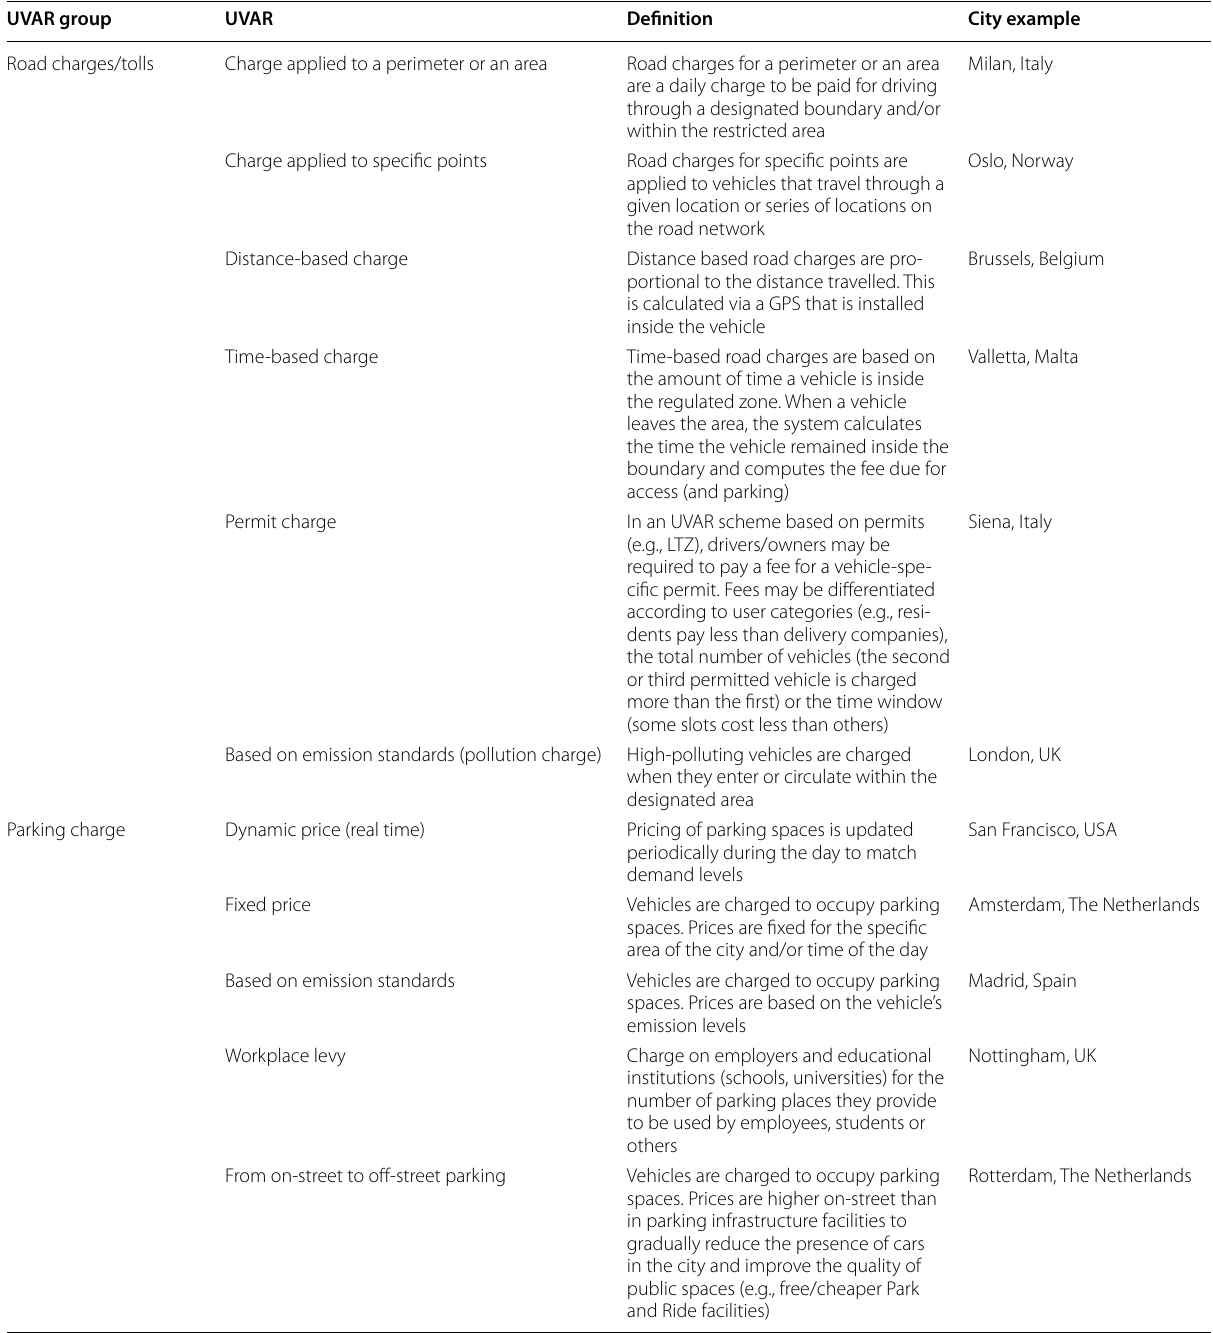
Table 3 UVAR for the pricing aspects category, showing the overarching group, definition and a city examplewhere the measure is